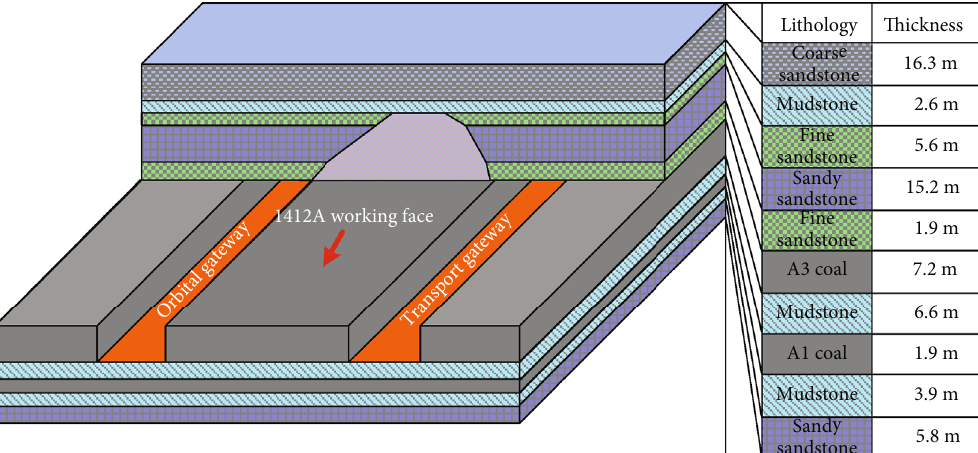
Figure 5: Working face layout and lithology histogram.